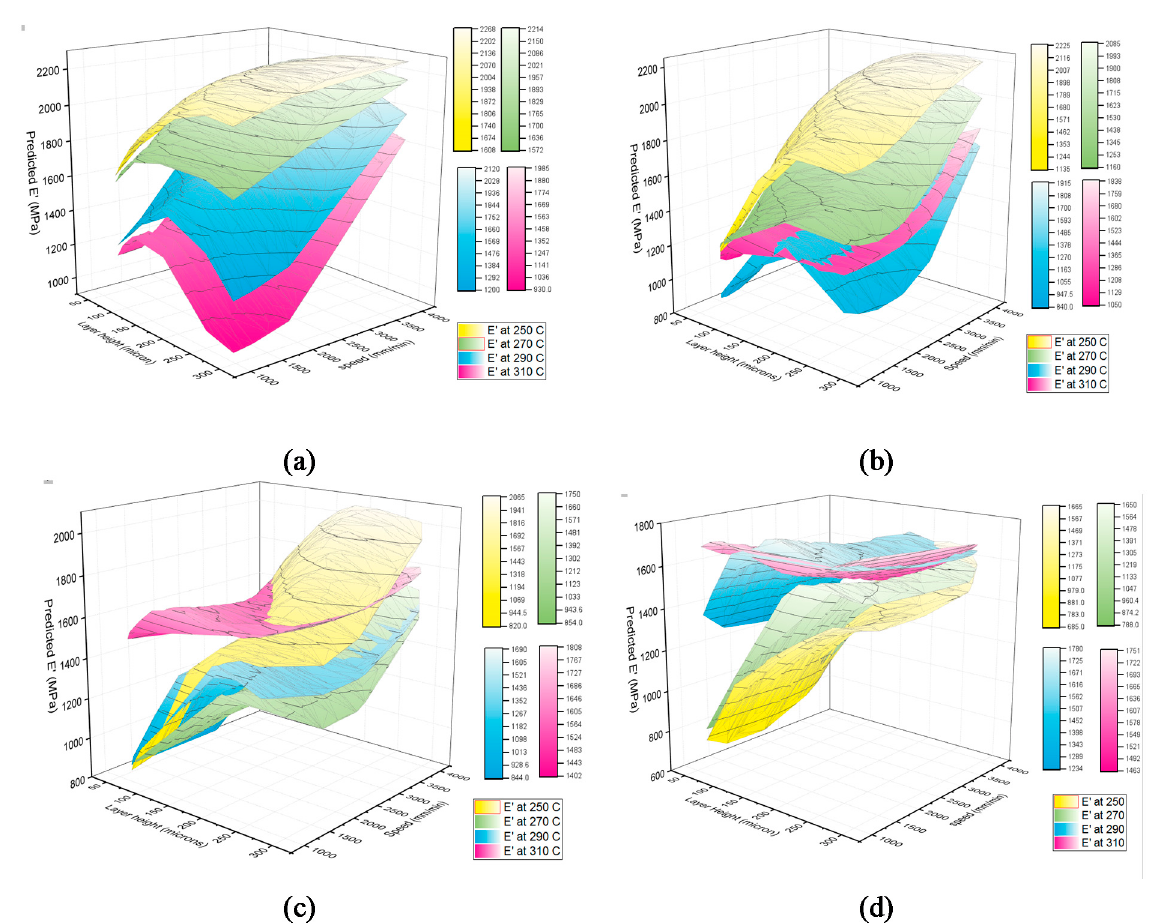
Figure 14. Simulated response of the storage modulus numeral network, at a working temperature of 40 ℃ and fixed nozzle temperatures (shown by different colors); ( a ) at 0 ° raster orientation, ( b ) at of 40 ◦ C and fixed nozzle temperatures (shown by different colors); ( a ) at 0 ◦ raster orientation, ( b ) at 90 ° raster orientation, ( c ) at 45 ° raster orientation, ( d ) at ±45 ° raster orientation. 90 ◦ raster orientation, ( c ) at 45 ◦ raster orientation, ( d ) at ± 45 ◦ raster